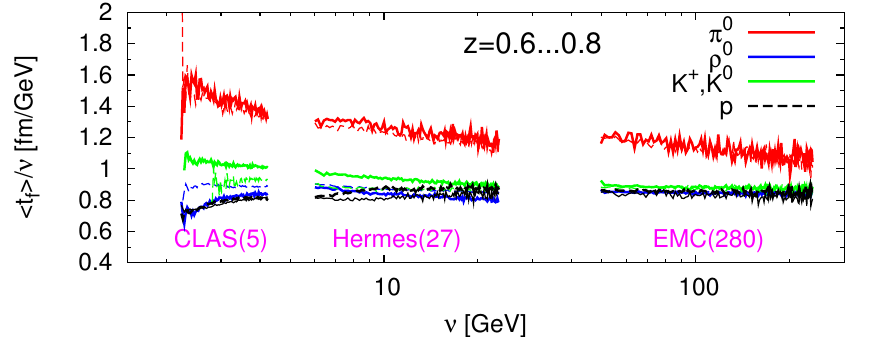
Figure 1. Average formation times, t f , in the laboratory frame as a function of energy transfer, ν , for an intermediate relative hadron energy z = E h / ν = 0.6 . . . 0.8 in three kinematical regimes for some hadrons. Here, E h is the energy of produced